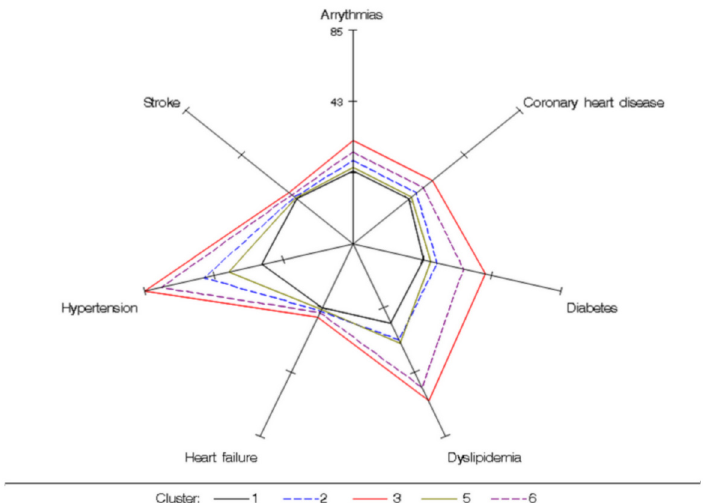
Fig 4. Conditional probabilities of co-morbidities to highlight the major differences among clusters. Cluster 4 was not represented in this figure because the probability to have cardiovascular and metabolic co- morbidities was near 0. Cluster 1: the young symptomatic. Cluster 2: the old obese. Cluster 3: the multi- disease (MD) old obese. Cluster 5: the drowsy obese. Cluster 6: the MD obese symptomatic